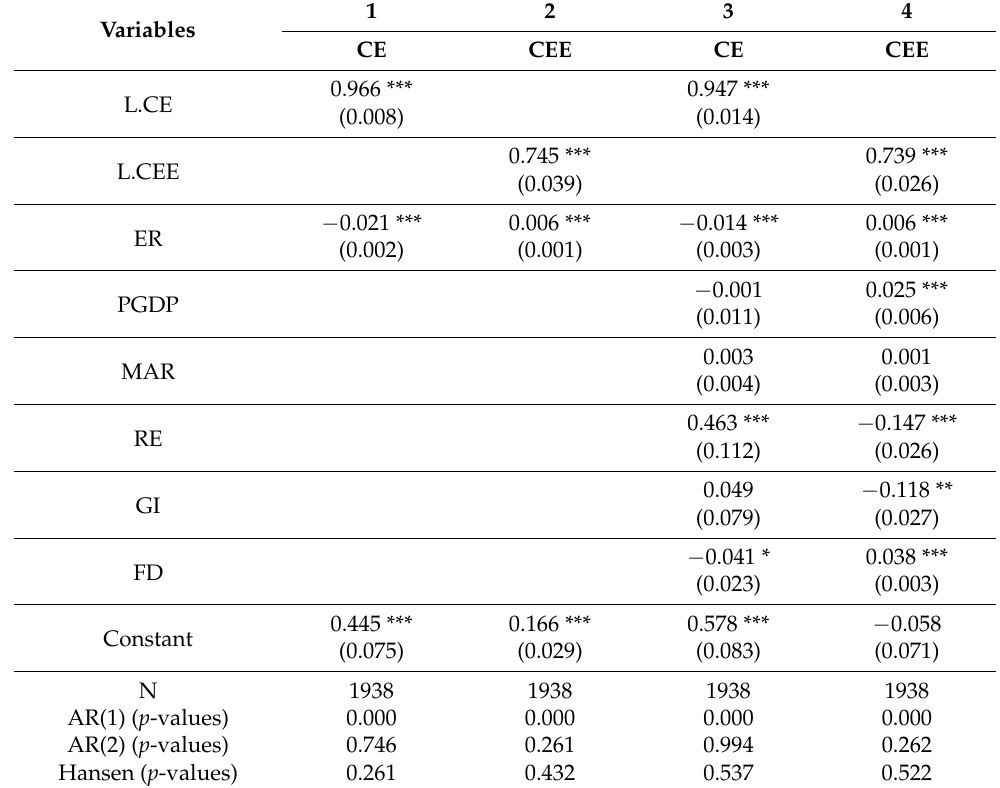
Table 4. Baseline